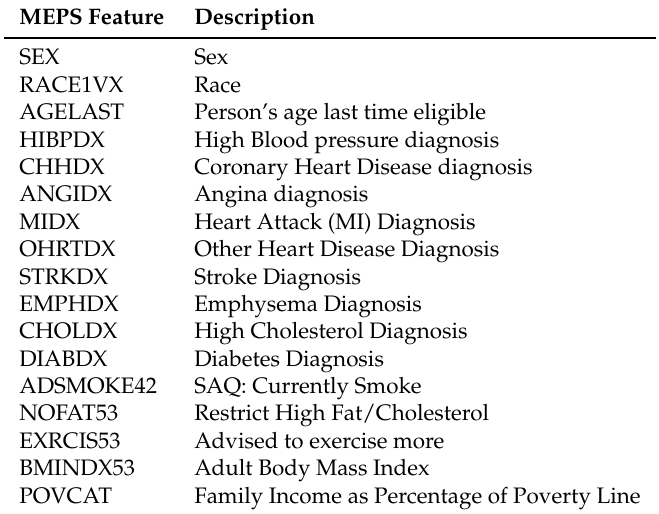
Table 2. Selected Demographics and Health Condition